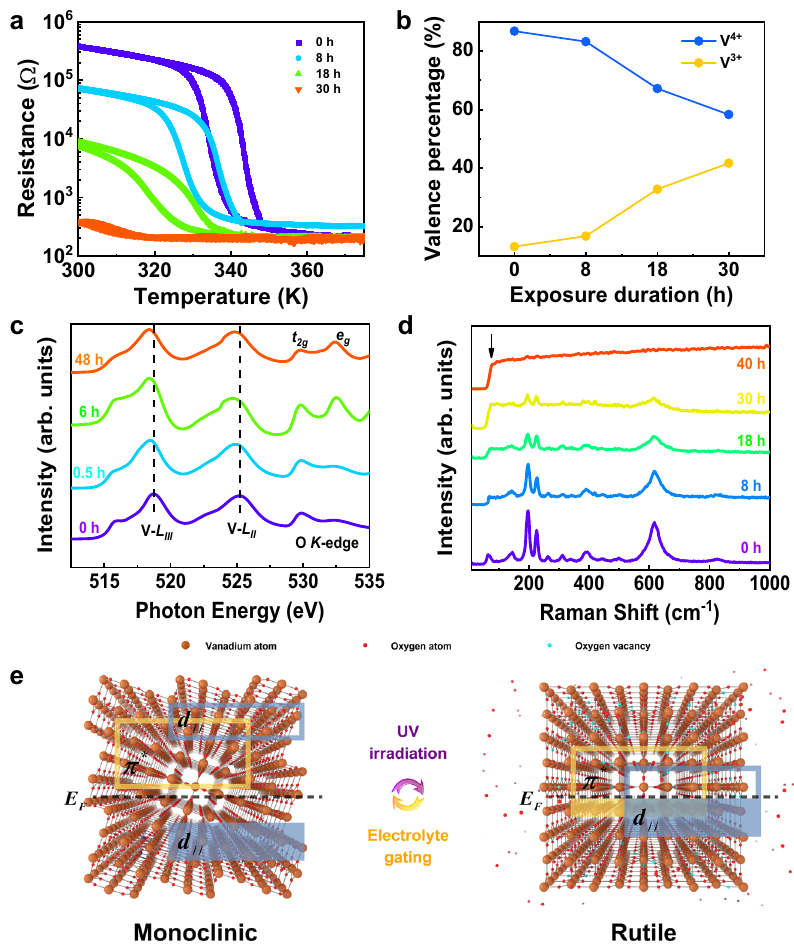
Fig. 3 Photo-induced non-volatile phase transition. a Temperature-dependent resistance in VO 2 fi lms at various exposure durations of UV light at 84 mW/cm 2 . b Integrated area percentage of vanadium valence peaks at different UV irradiation duration. c V L -edge and O K -edge XAS curves for VO 2 fi lms at different UV irradiation durations (intensity of 100 mW/cm 2 ). d Raman spectra at different UV irradiation durations (84 mW/cm 2 ). e Schematic diagram of the reversible non-volatile phase transition driven by optical and electrolyte